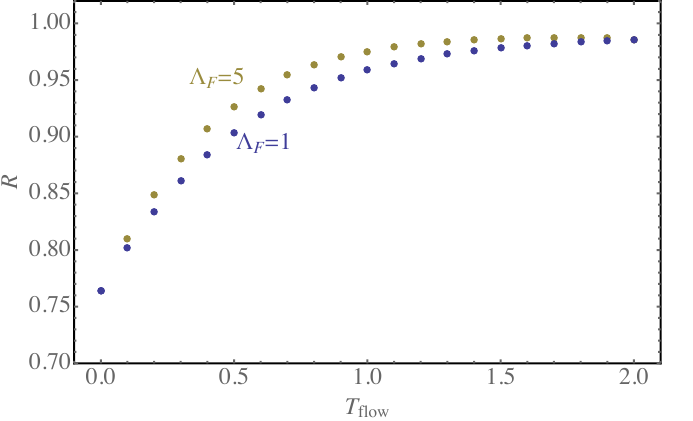
Figure 9 . T (cid:13)ow -dependence of the reweighting factor for the U(1) one-link model with (cid:20) = 1 = 2 and (cid:3) B =